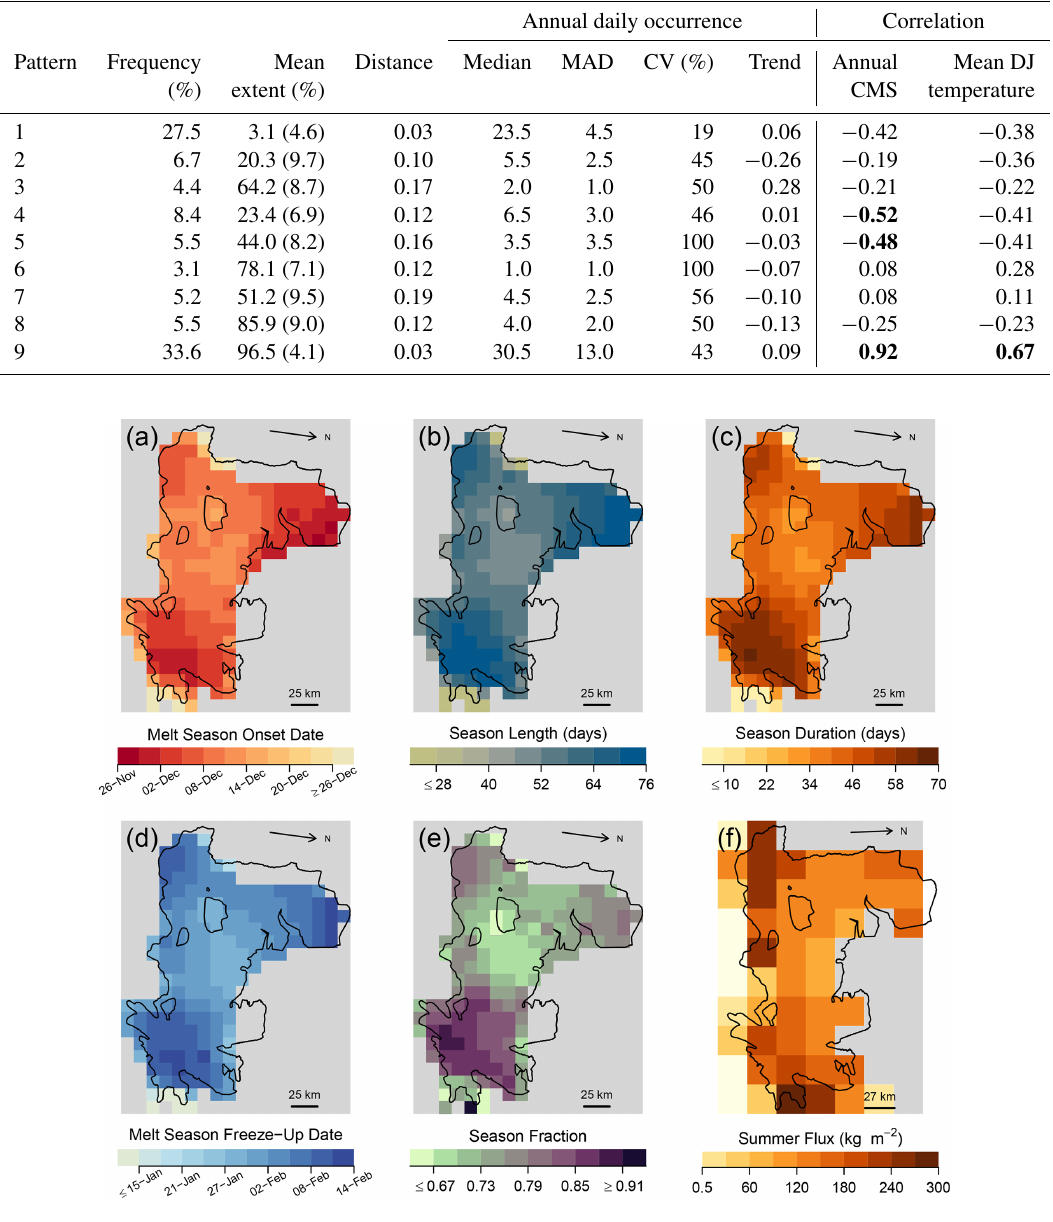
Figure 6. Average values across all melt seasons on a per-pixel basis, for (a) melt season onset date; (b) melt season length; (c) melt season duration; (d) melt season freeze-up date; (e) the fraction of the melt season experiencing melt, equivalent to (c) divided by (b) ; and (f) average cumulative summer (NDJF) melt flux from RACMO2.3p3 (van Dalum et al., 2021). Note that (a–e) include data for summers 2002/03– 2010/11 and 2012/13–2020/21, whereas (f) includes data for 2002/03–2017/18; correlations between (c) and (f) discussed in Sect. 5.4 use contemporary